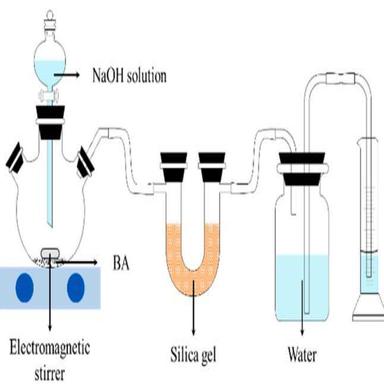
Setup of the dissolution test to determine the metallic Al content.